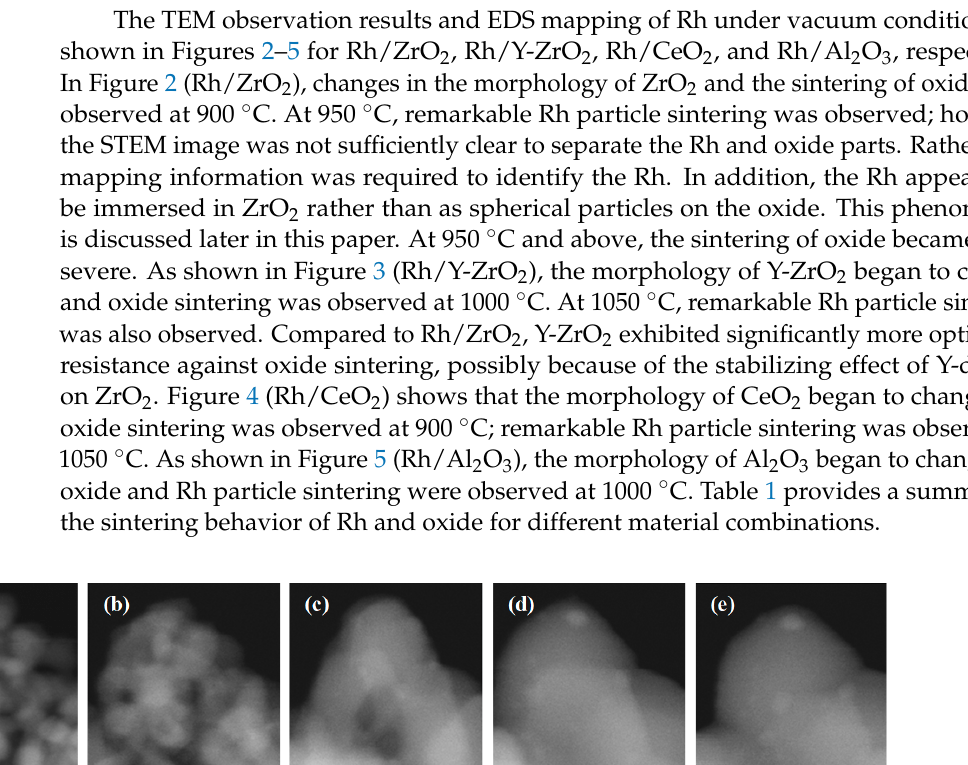
Figure 3. TEM images and EDS mapping of Rh in Rh/Y-ZrO 2 under vacuum conditions at ( a ) 300 °C, ( b ) 900 °C, ( c ) 950 °C, ( d ) 1000 °C, and ( e ) 1050 °C. Figure 4. TEM images and EDS mapping of Rh in Rh/CeO 2 under vacuum conditions at ( a ) 300 °C, ( b ) 900 °C, ( c ) 950 °C, ( d ) 1000 °C, and ( e ) 1050 °C.